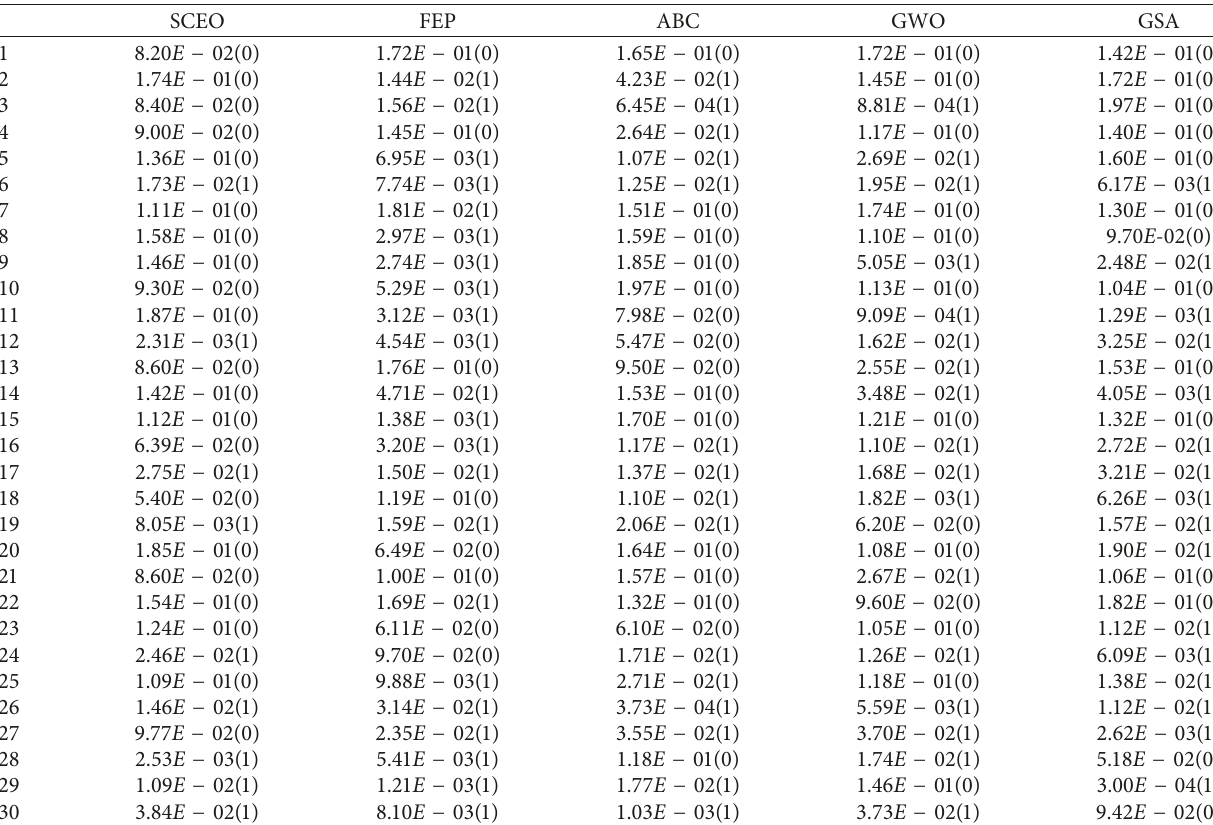
Table 13: Shapiro–Wilk test for SCEO, FEP [15], ABC [29], GWO [7], and GSA [30] samples.